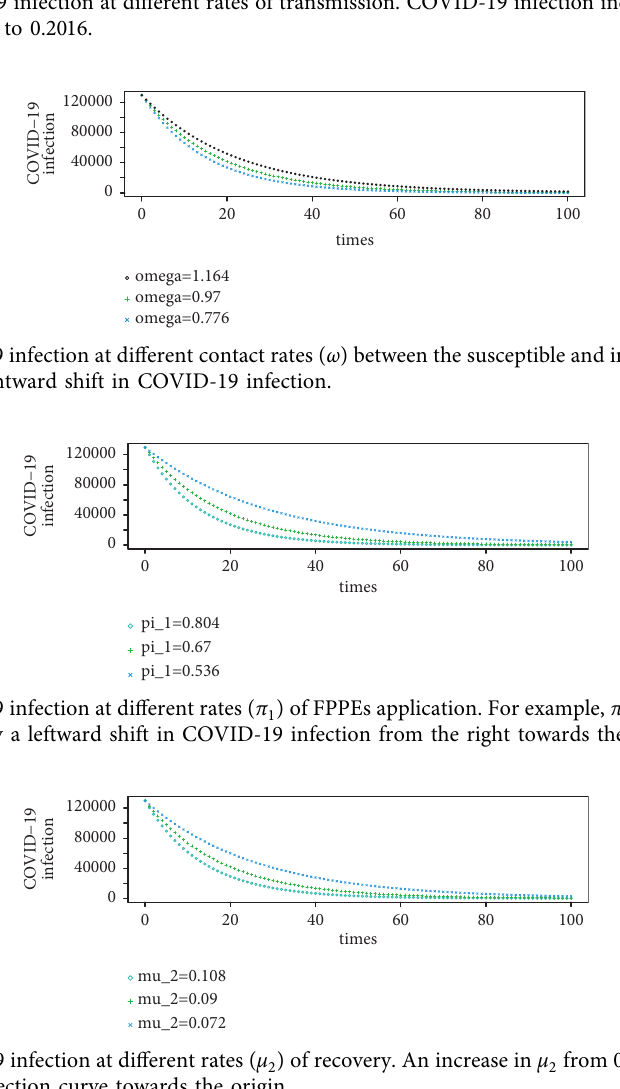
from 0.072 to 0.108 is associated with an 2